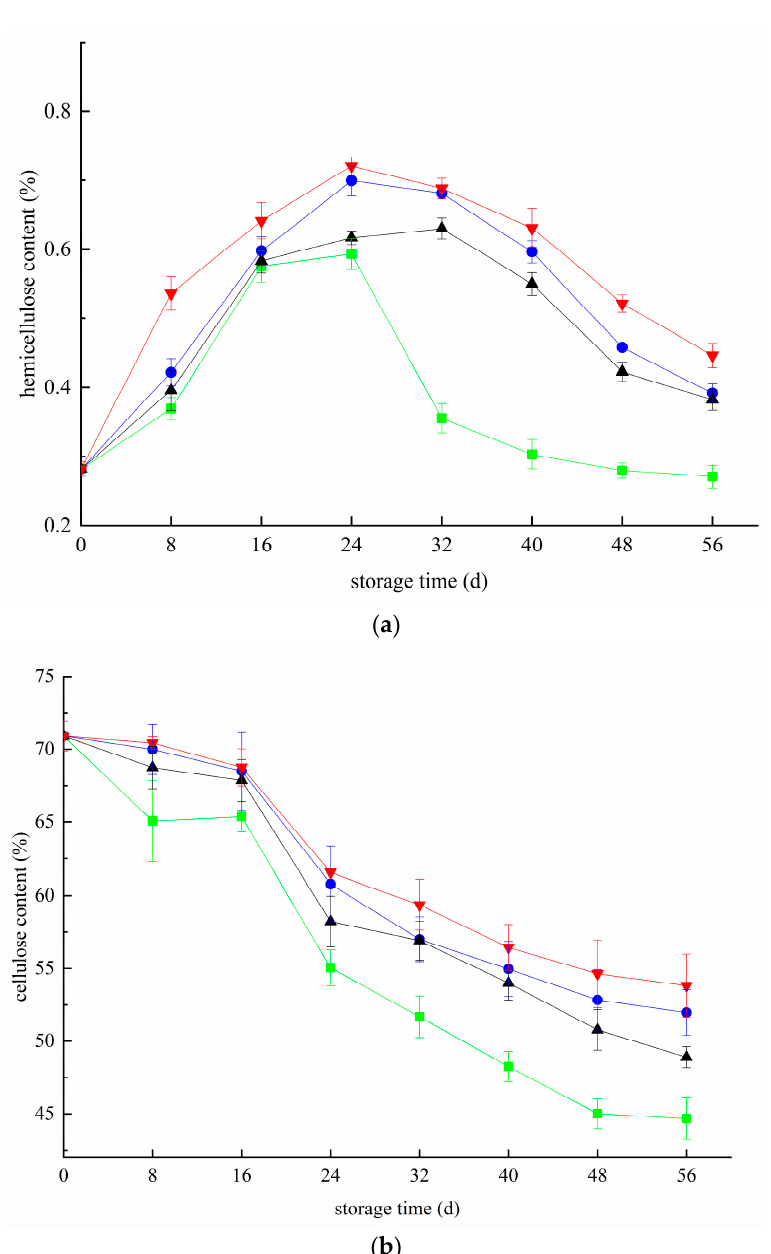
Figure 3. Effect of hemicellulose and cellulose in blueberry under different treatments ( a , b ). ( a ) : Change plot of hemicellulose content in blueberry; ( b ) Change plot of cellulose content in blueberry . ■ : control; ● : T; ▲ : Z: ▼ : T plus Z.